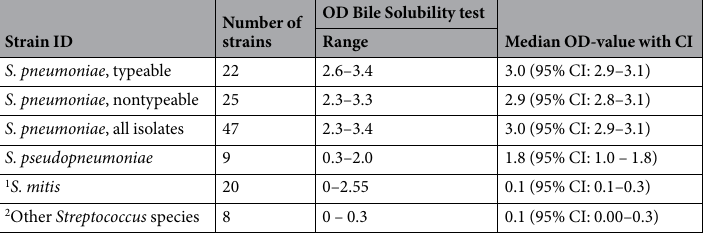
Table 1. Mean OD-values for the species tested in the study. The species annotation of strains was based on MALDI-TOF output and spectra. For detailed results per species, see supplementary Table 1. 1 Three strains were autolysin (lytA) positive. 2 Four S. sanguinis , two S . australis , two S . oralis .